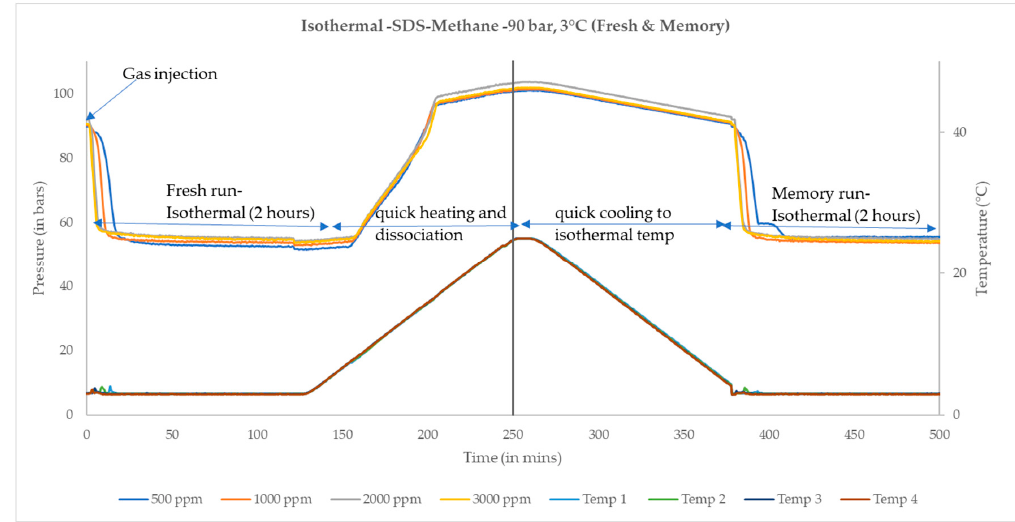
Figure 3. Graphical representation of typical identical isothermal experiments at 90 bar and 3 °C for different sodium dodecyl sulfate (SDS) concentrations (fresh and memory).